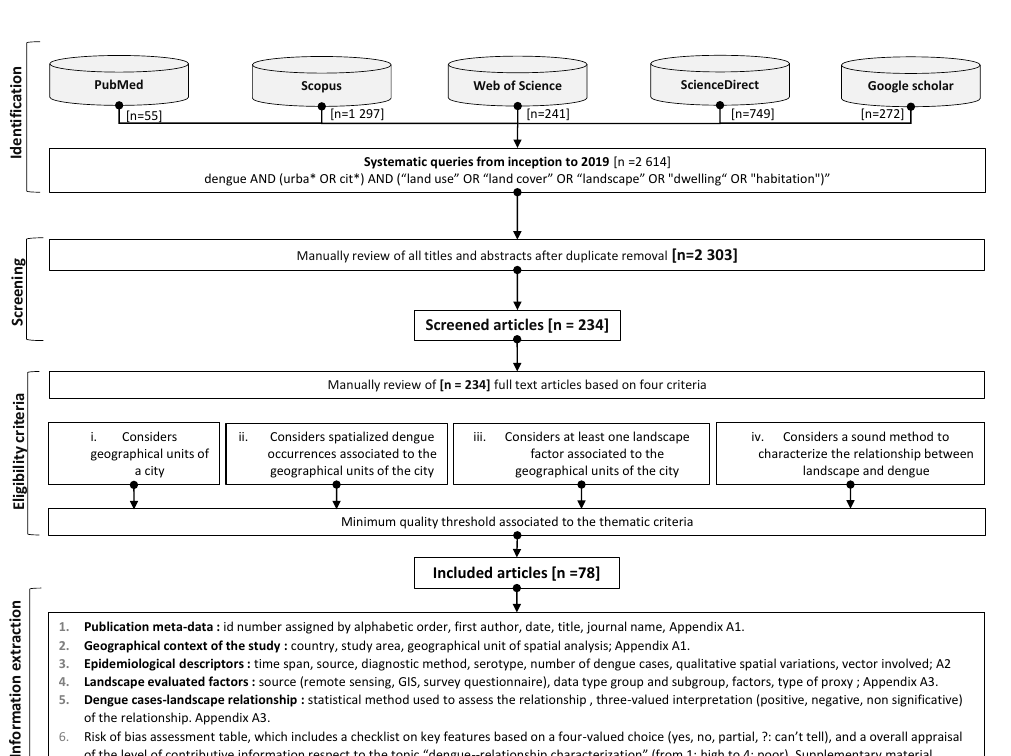
Figure 1. Stages of systematic search to retrieve included article to our four criteria, following the PRISMA statement